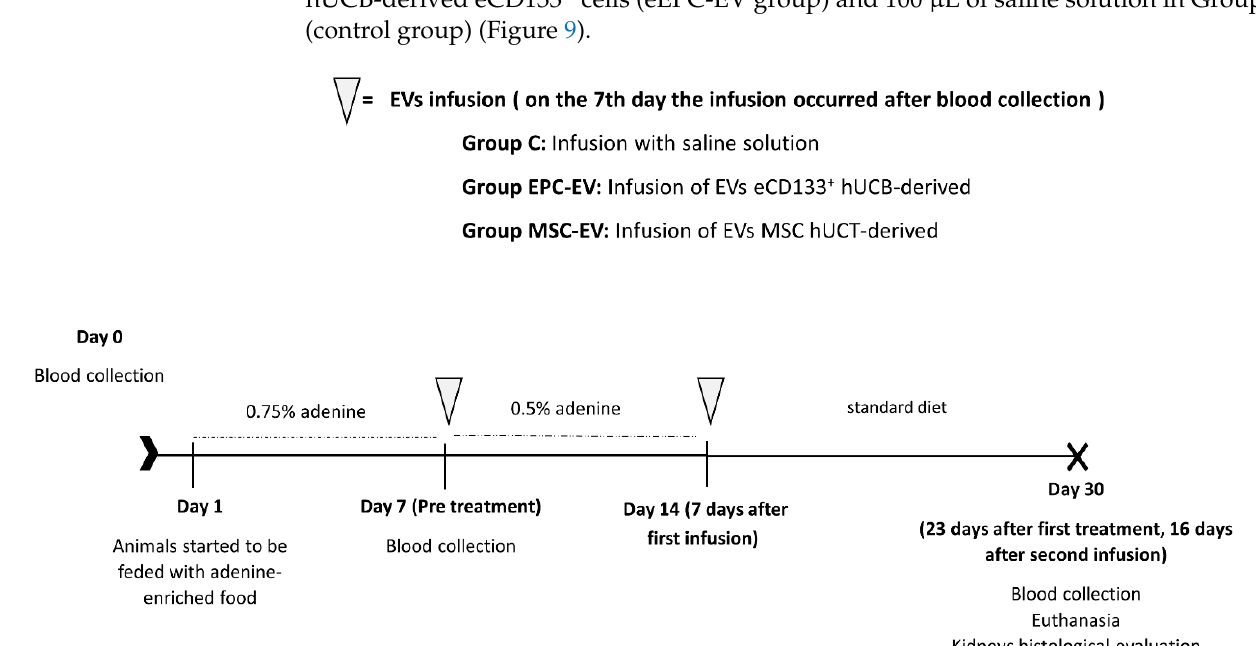
Figure 9. Study design chronic kidney disease induction using adenine and post treatment with extracellular vesicles from hUCT-derived MSCs and hUCB-derived eCD133 + cells in Wistar rats. Weighing and blood collection (Days 0, 07 and 30), extracellular vesicle infusion (Days 07 and 14), and euthanasia (Day 30) were performed.